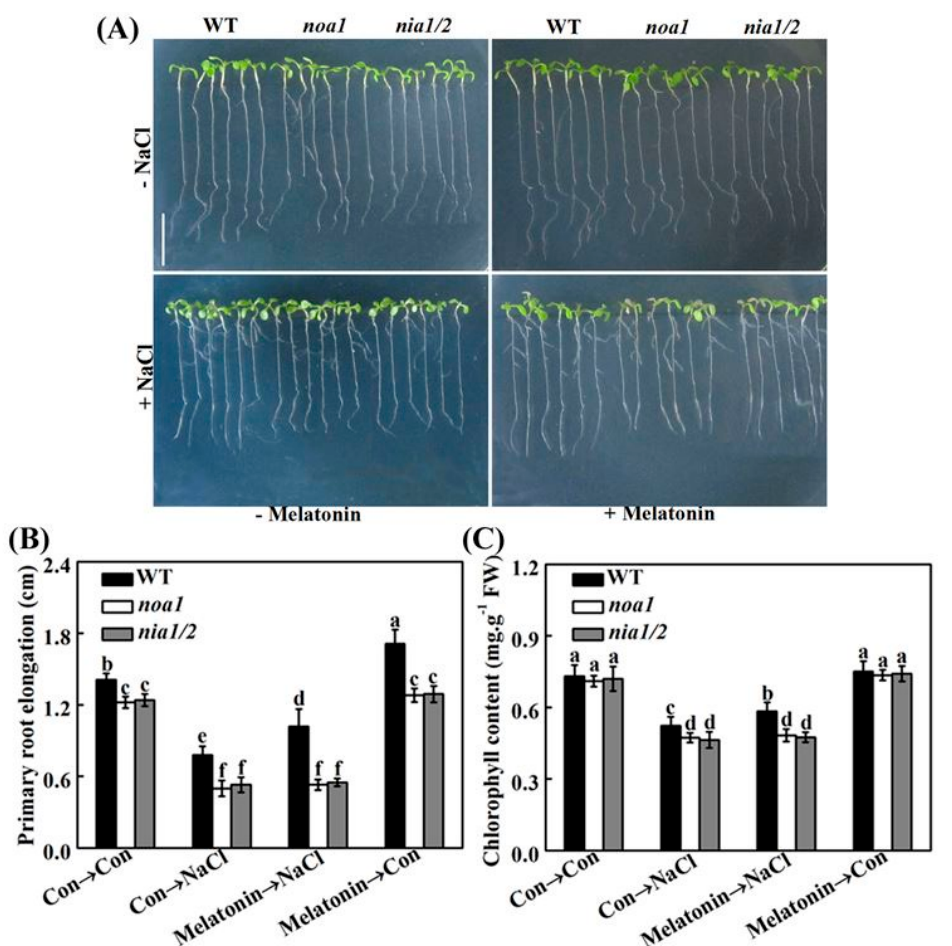
Figure 10. Genetic evidence supported the requirement of NO in melatonin-alleviated NaCl stress. Five-day-old wild-type (WT), and noa1 and nia1/2 mutant plants were grown on MS medium supplemented with 1.0 μ M melatonin for 5 days, and then transplanted to medium in the presence or absence of 125 mM NaCl for another 5 days. Primary root elongation ( B ) and total chlorophyll content in leaves ( C ) were then determined to assess changes in salt tolerance described in ( A ). Control seedlings (Con) were grown in MS medium alone. Scale bar = 1 cm. Data are means ± SE of three independent experiments with at least three replicates for each. Bars with different letters are significant different at p < 0.05 according to Duncan’s multiple range test.